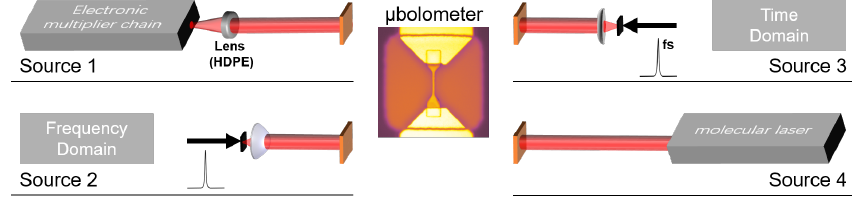
Figure 2. Experimental set-up for imaging of terahertz beam profiles using different THz emitters. Source 1—electronic multiplier chain emitting radiation of 0.15 THz, 0.3 THz and 0.6 THz frequencies